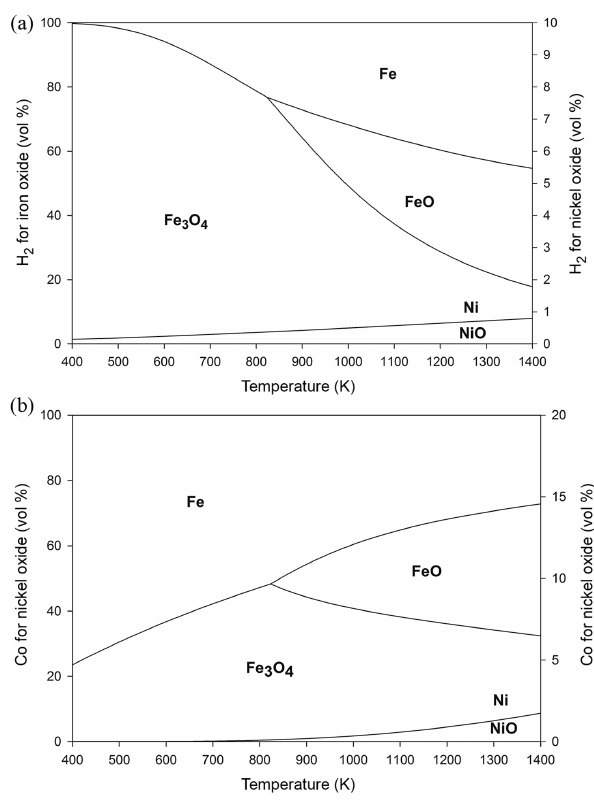
Figure 1: Stability diagrams for Fe – O and Ni – O in hydrogen (a) and carbon monoxide